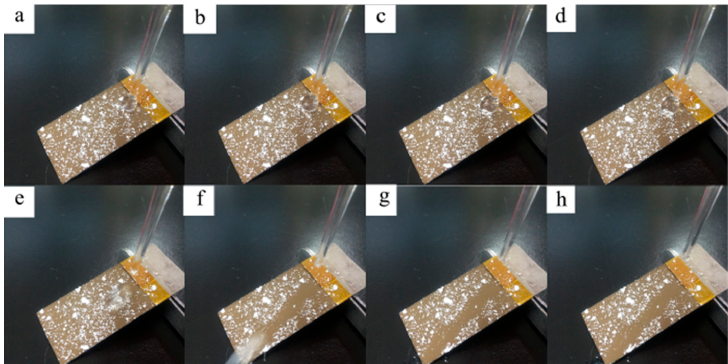
Figure 10. The time sequence of the self-cleaning process on the superhydrophobic surface at a sliding angle about 5°.